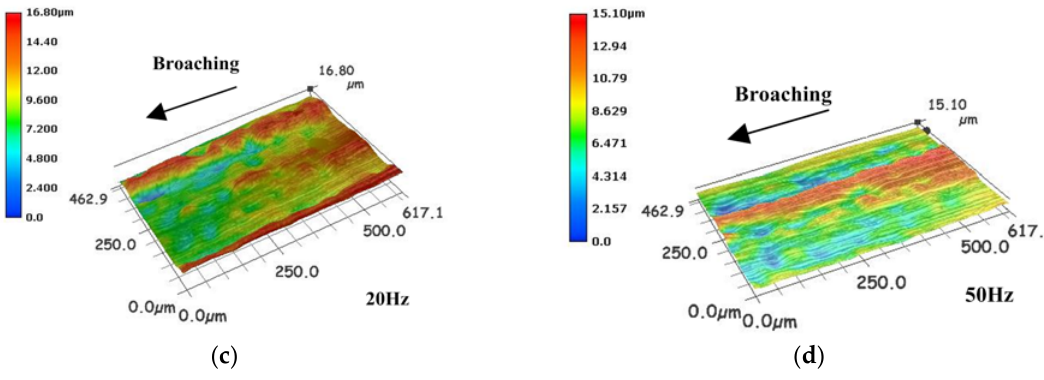
Figure 9. Workpiece surface (al) of ( a ) CB, ( b ) 10 Hz, ( c ) 20 Hz and ( d ) 50 Hz.